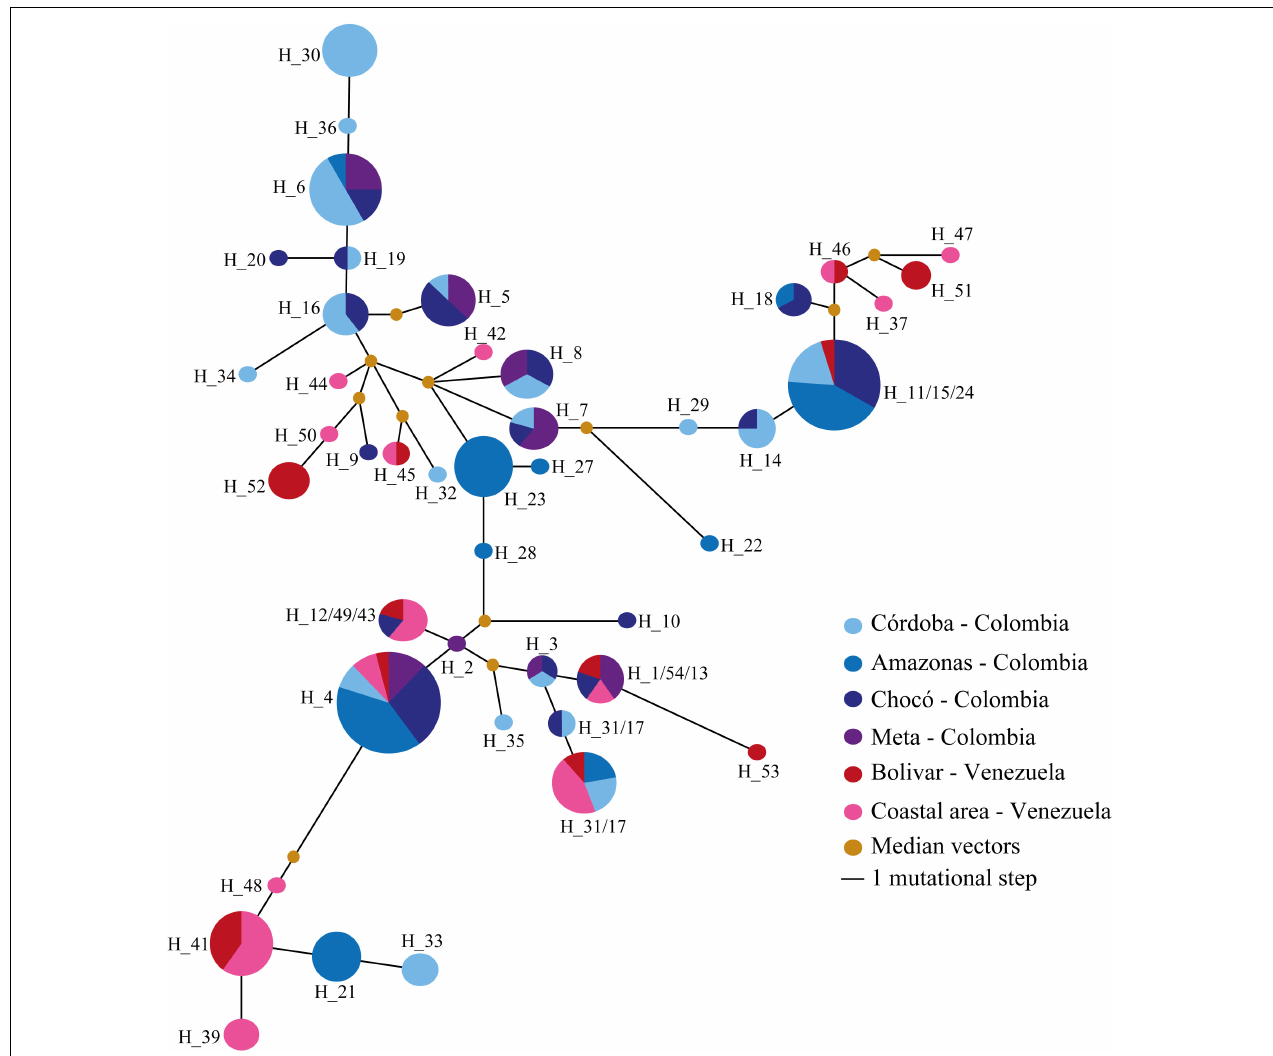
FIGURE 3 | Median-joining network for Colombian and Venezuelan subpopulations. The Figure shows the pvrbsa haplotypes identified from Colombian and Venezuelan isolates. Some haplotypes were included within another haplotype using the contraction star algorithm (Forster et al., 2001) for simplifying network interpretation. Each node is a haplotype and its size indicates its frequency. The lines connecting the haplotypes represent the different mutational paths and the median vectors are the ancestral sequences explaining the relationship and evolutionary